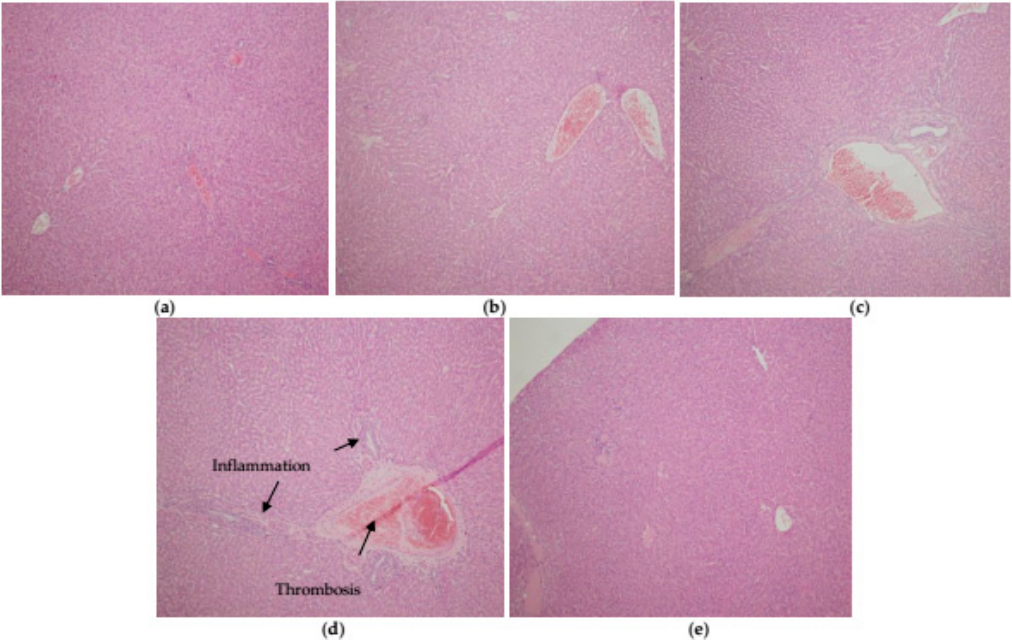
Figure 5. Effect of Cd or/and Pb on microstructures of rats liver after acute exposure. Panel ( a ): control group; panel ( b ): Cd 15 group; panel ( c ): Cd 30 group; panel ( d ): Pb 150 group; panel ( e ): Cd 15 +Pb 150 group.